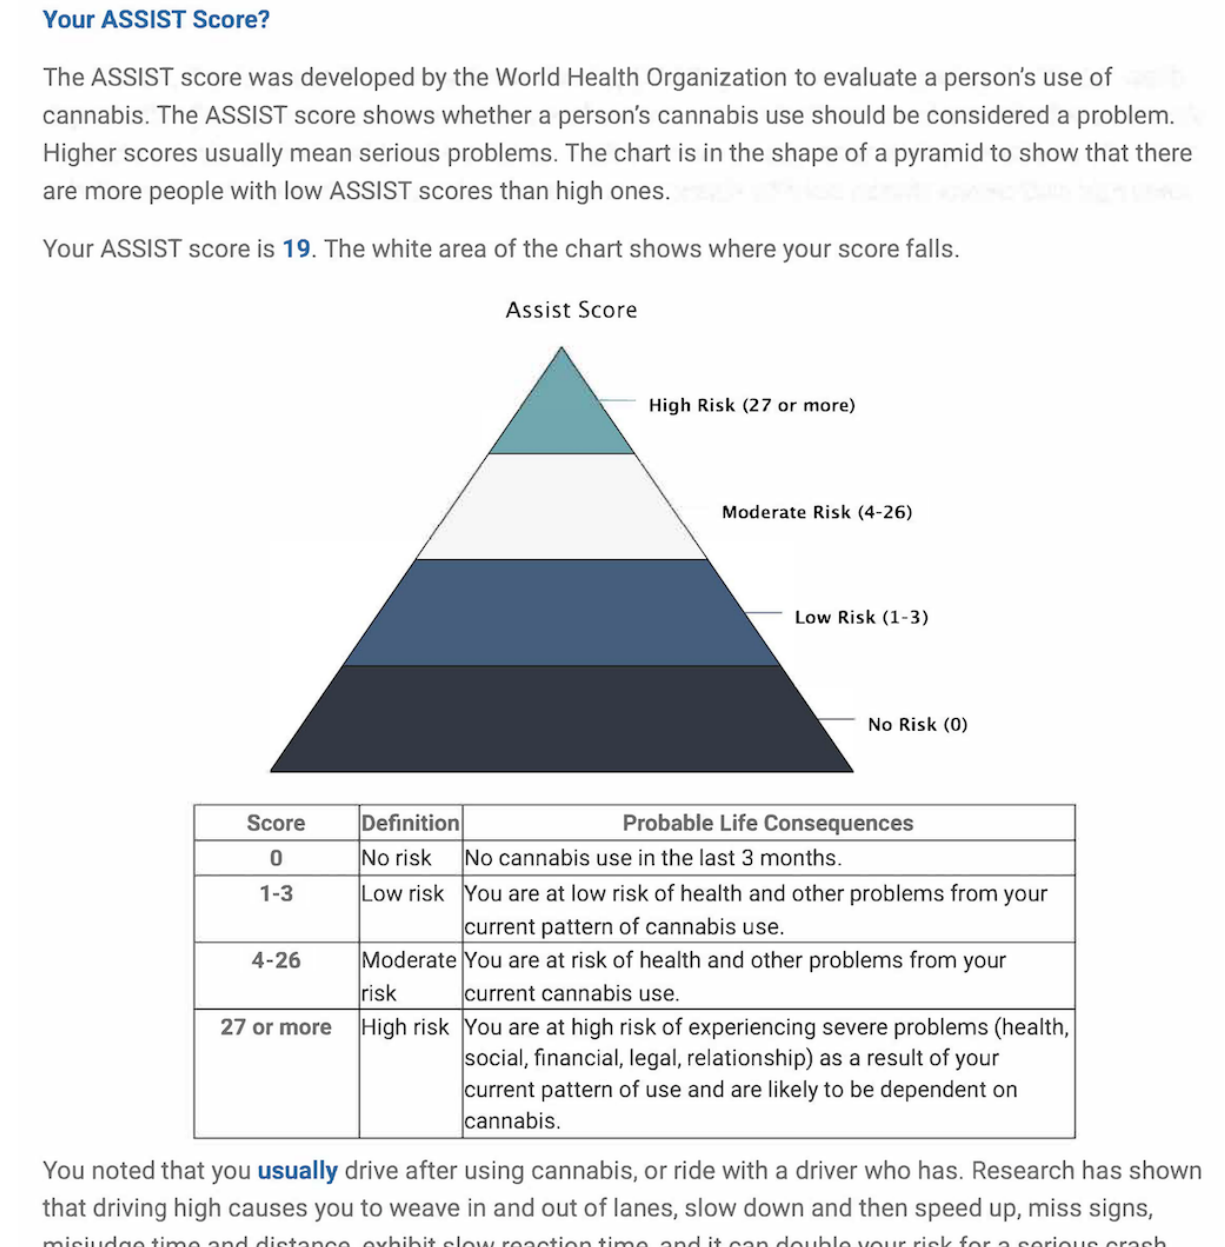
Figure 1. Check Your Cannabis ASSIST score. ASSIST: Alcohol, Smoking, and Substance Involvement Screening